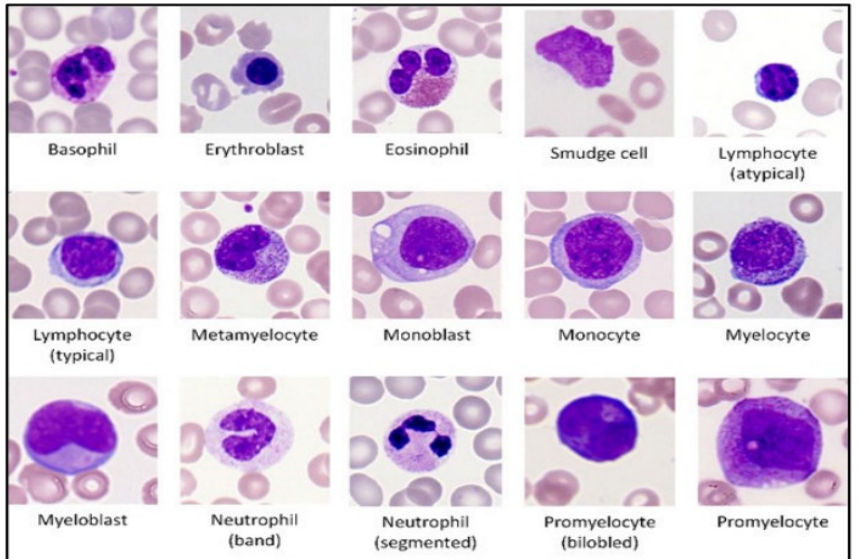
Figure 1. Samples of the fifteen different types of WBCs presented in the dataset, including normal and abnormal cells [5].